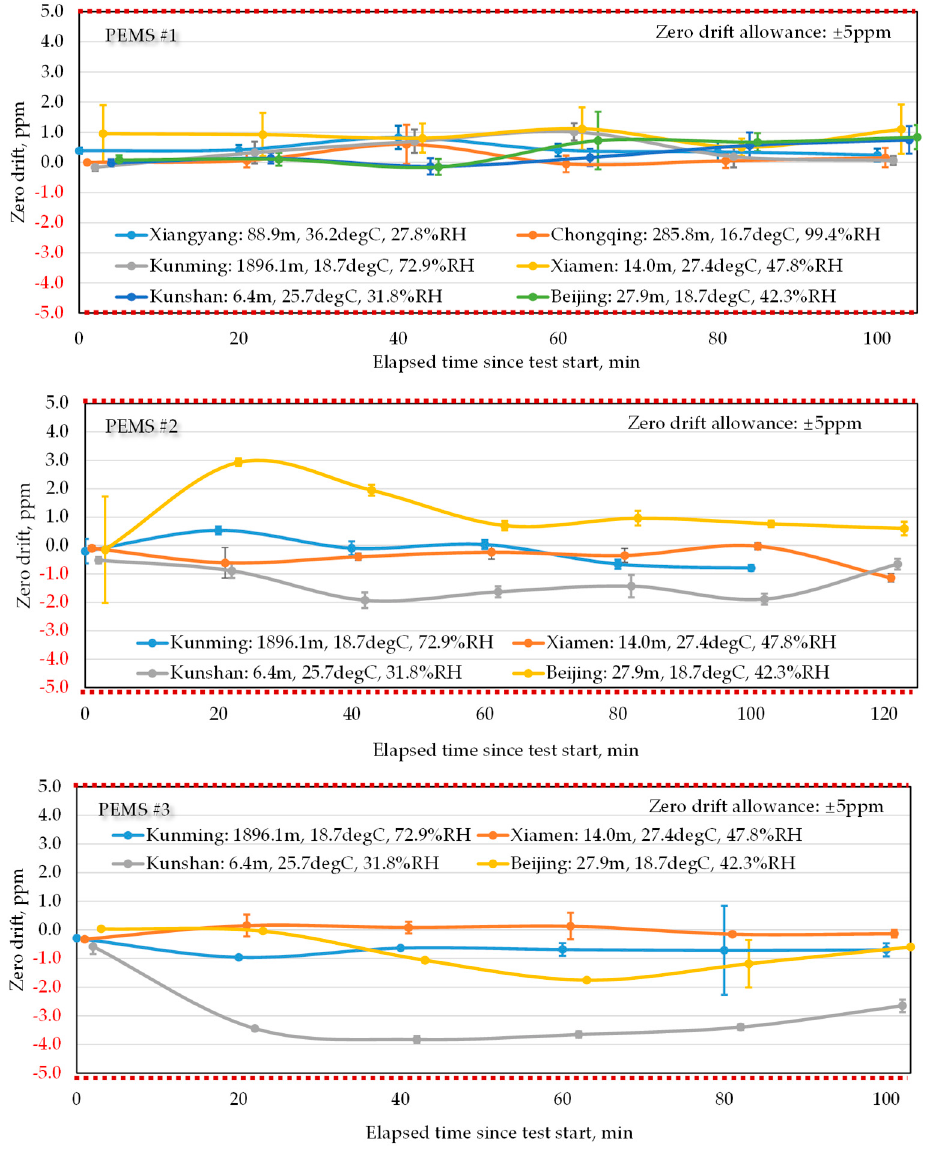
Figure 2. Zero drifts of three PEMSs from different manufacturers obtained with on-road periodic zeroing; 5 min zeroing after a 15 min drive (legend: city name, altitude, temperature, humidity).